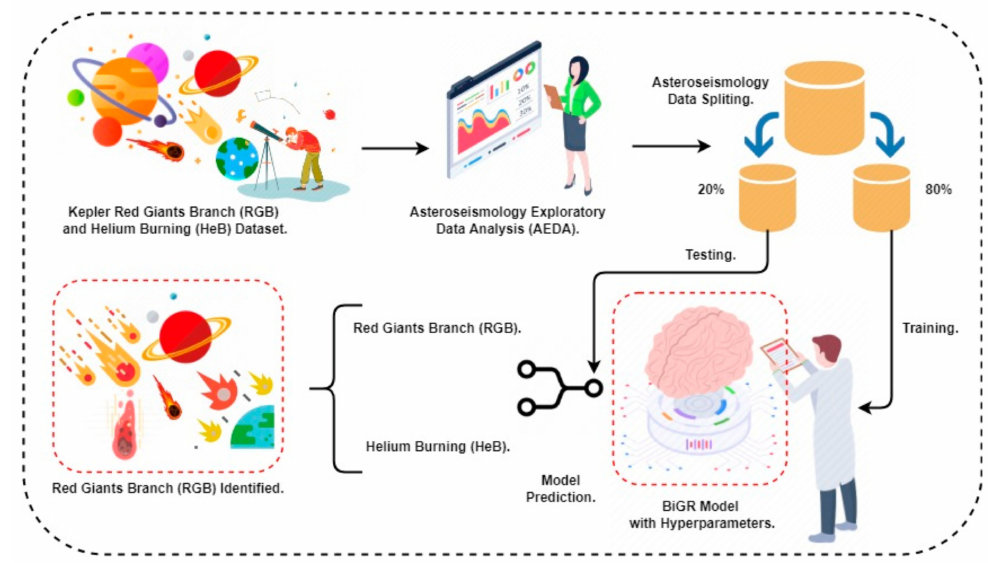
Figure 1. The methodology architecture analysis of the proposed research study in the context of